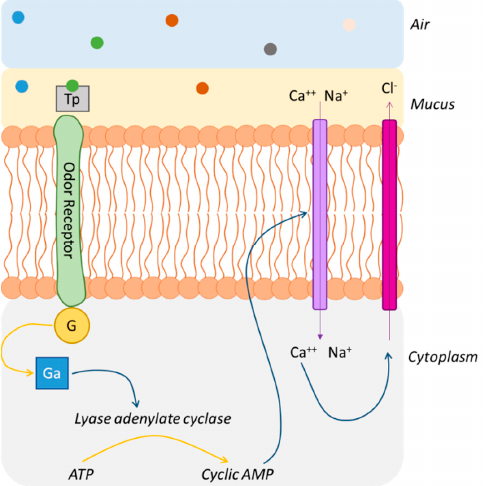
Figure 7. Cascade of reactions occurring when an odorant molecule enters the nasal cavity. Odorants cross the mucus directly or via transport proteins (Tp) and then reach the odor receptor, which undergoes structural modifications and activates G proteins (G). An active subunit (Ga) is liberated, activating the lyase adenylate cyclase, resulting in the conversion of adenosine triphosphate (ATP) into cyclic adenosine monophosphate (cAMP). The cAMP is able to open cyclic nucleotide-gated ion channels, allowing Ca 2 + and Na + ions to enter the cell, which results in the depolarization of the odor receptor neuron (ORN) and transmission of the information to the